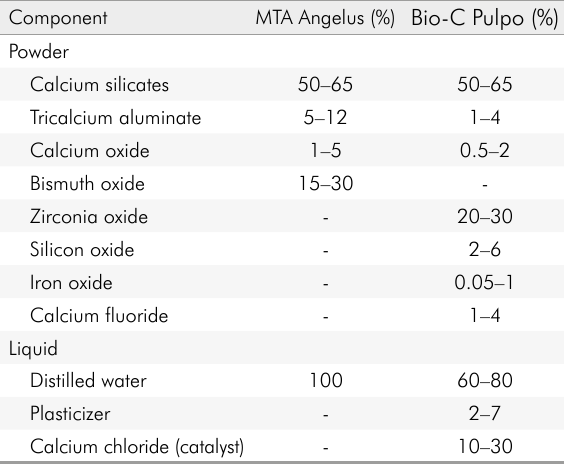
Table 1. Chemical composition of white MTA Angelus and Bio-C Pulpo